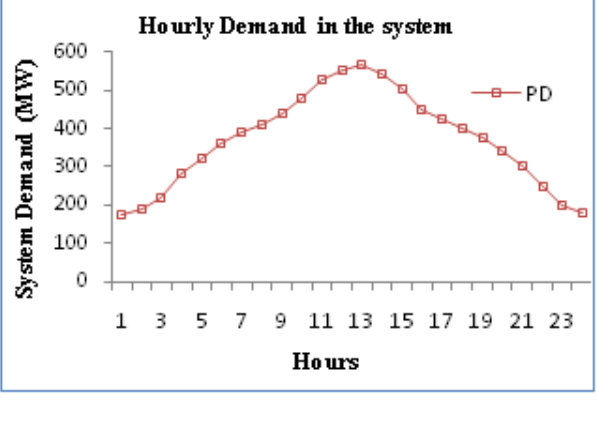
Figure 1. Hourly demand of the system